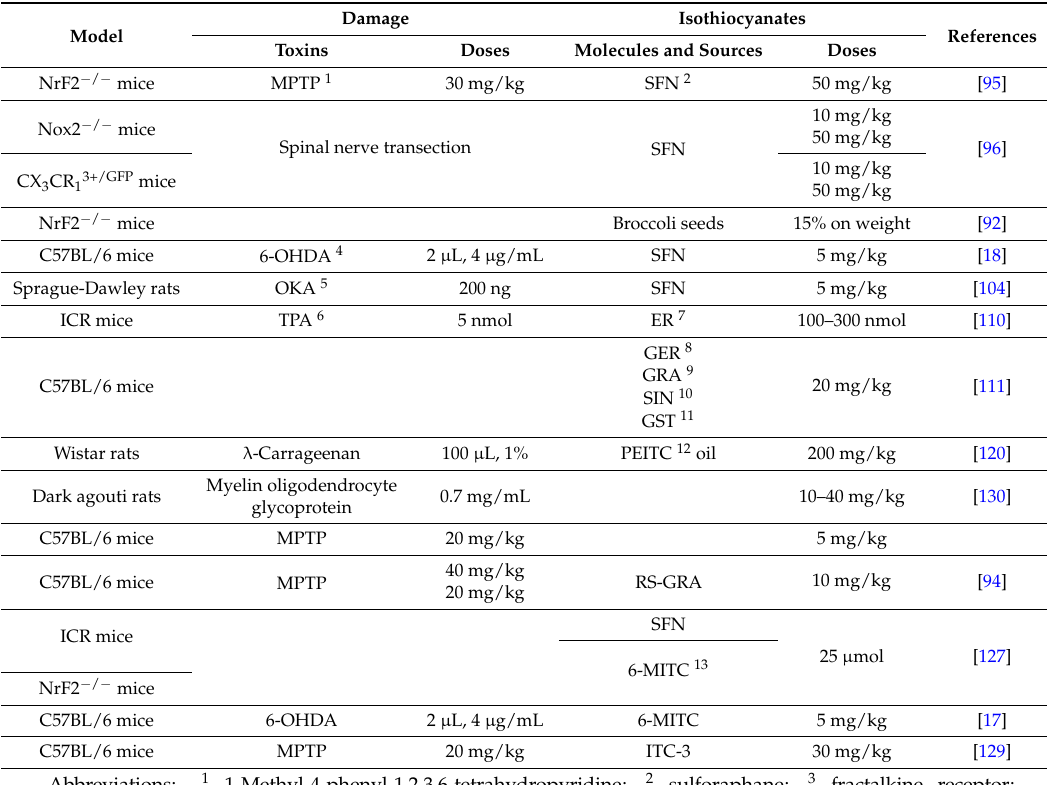
Table 2. Summary of experimental models in vivo and isothiocyanate (ITC) doses.